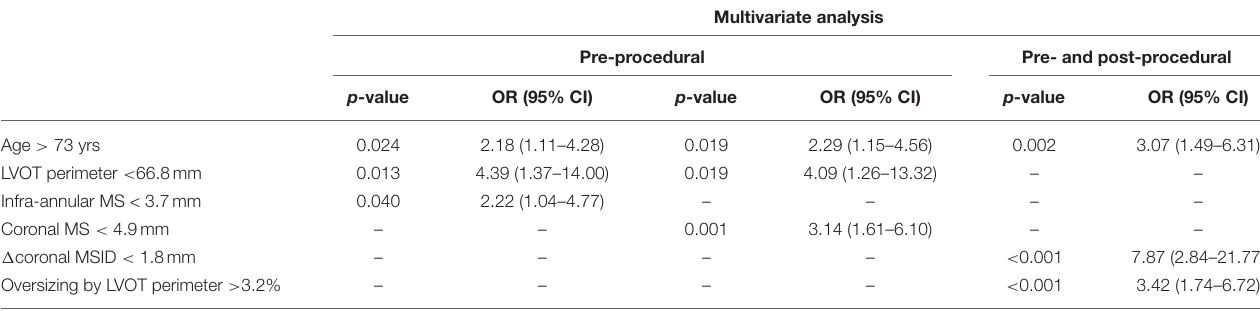
TABLE 4 | Multivariate logistic regression for predictors of new-onset conduction